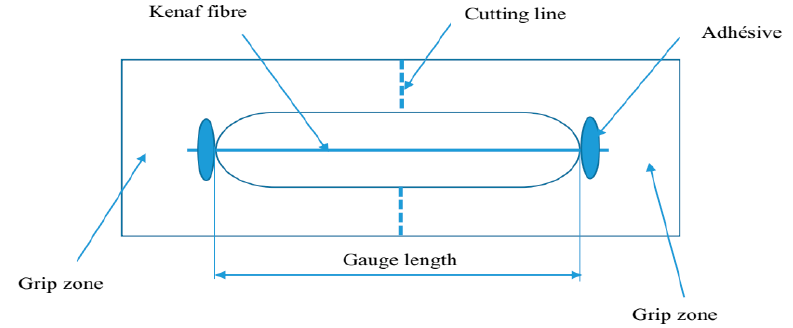
Figure 1. Tensile test and gripping tab specimens for kenaf fibers.